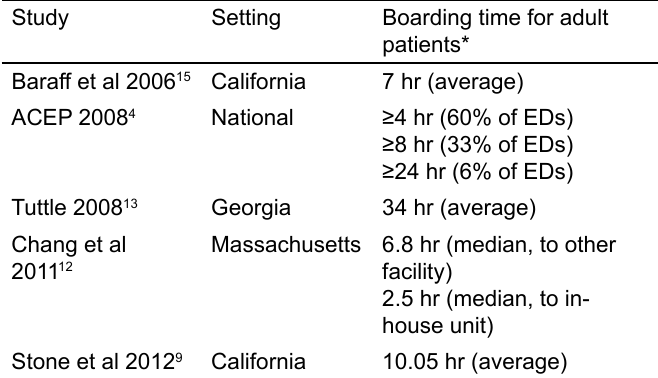
Table 1: Studies of boarding times for psychiatric patients in the emergency department